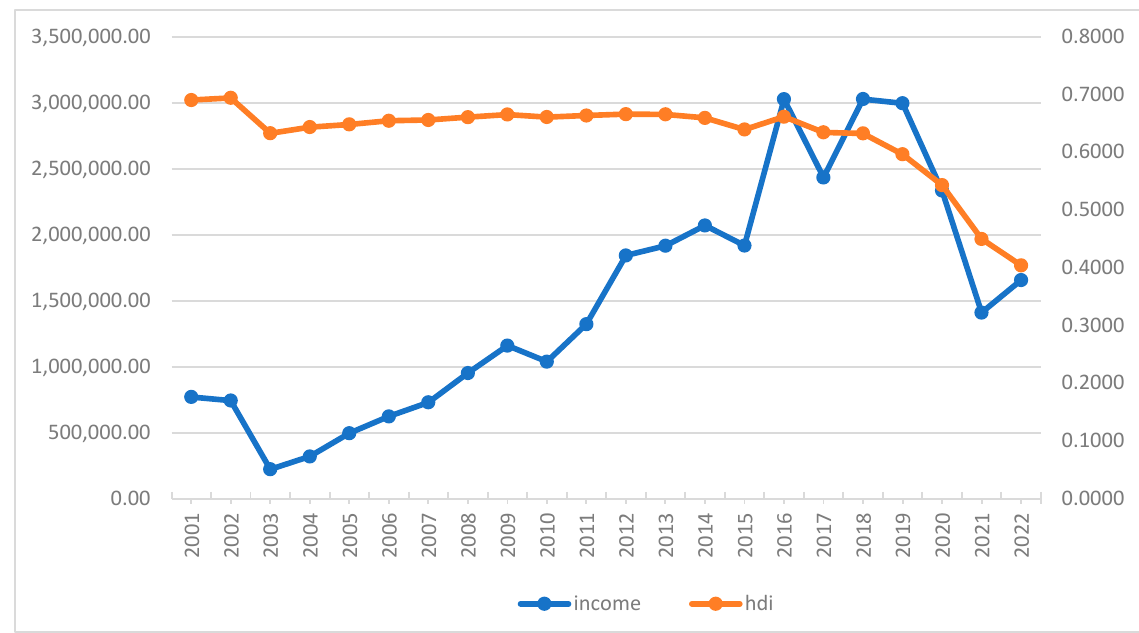
Figure 9. HDI and FRA Great Chaco 2001–2021. Source: DNCFP.